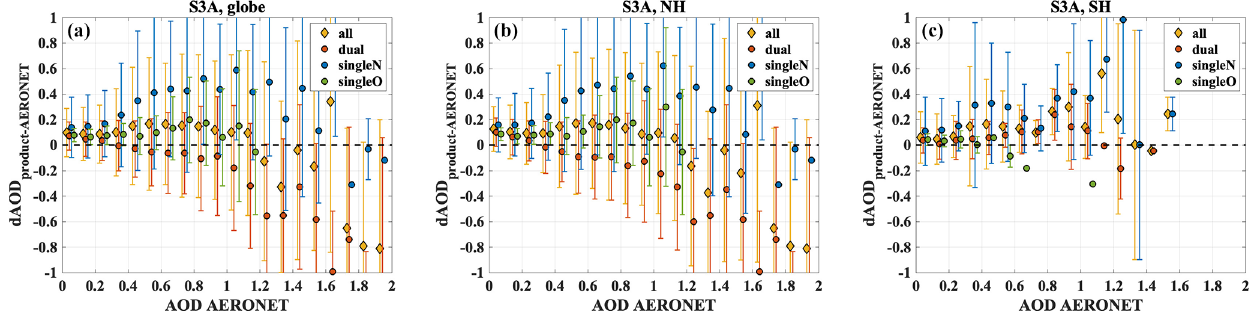
Figure 3. For S3A, binned in 0.1 aAOD intervals, syAOD offsets (dAOD) for the globe (a) , the NH (b) , and SH (c) for all matchups, as well as the dual, singleN, and singleO groups of matchups (yellow rhombus, red, green, and blue dots, respectively; see legend).